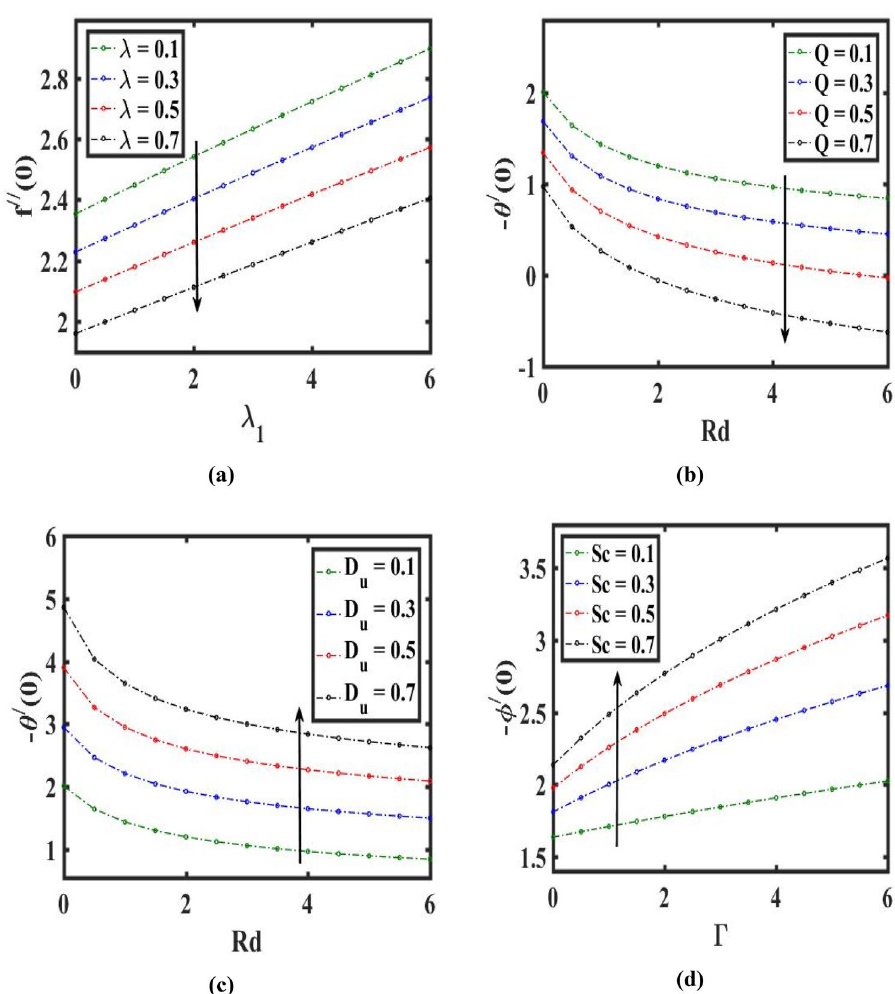
θ ′ ( 0 ) and mass transfer −